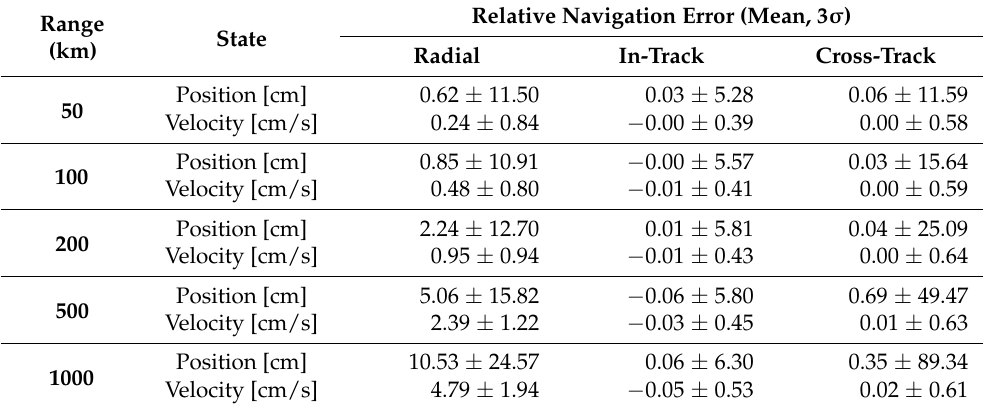
Table 7. Simulation results of the relative navigation by inter-satellite